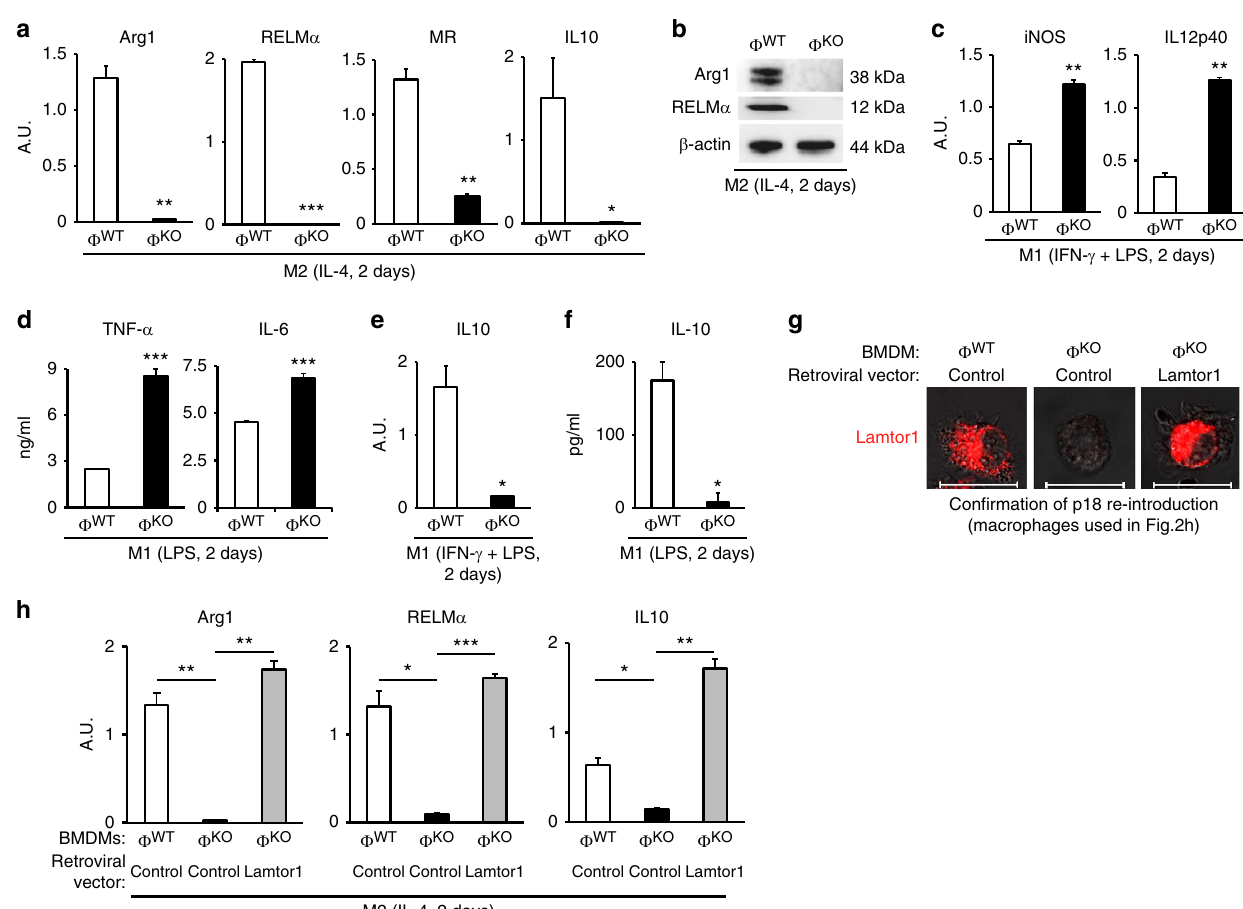
Figure 1 | Defective M2 polarization of Lamtor1-deficient macrophages. Expression levels of M2 signature genes in IL-4 (cid:2) stimulated BMDMs were measured by real-time PCR ( a ), and by western blots ( b ). ( c , d ) M1 polarization was enhanced in Lamtor1-deficient BMDMs. Expression levels of M1 signature genes were measured by real-time PCR ( c ), and cytokine concentrations in culture supernatants were measured by ELISA ( d ). ( e , f ) Expression of the immunosuppressive cytokine IL-10 in M1 (inflammatory) condition was largely reduced in Lamtor1-deficient BMDMs: real-time PCR for the transcript of IL10 ( e ), and ELISA for IL-10 concentration in culture supernatant ( f ). ( g ) Retroviral transfer of Lamtor1 gene into Lamtor1-deficient BMDMs restored Lamtor1 protein, confirmed by immunofluorescence. Scale bars indicate 20 m m. See Method section for more detailed information about the gene transfer. ( h ) Real-time PCR showed that re-introduction of Lamtor1 as in ( g ) rescued expression of M2 marker genes, confirming essential role of Lamtor1 in M2 polarization. The control retroviral vector expressed GFP protein. In ( d , f ), 100ngml (cid:2) 1 of LPS was used as stimulant. The representative results of three independent experiments are shown for each panel. F WT and F KO are defined as in Figure 1. * P o 0.05, ** P o 0.01, *** P o 0.001. Error bars show